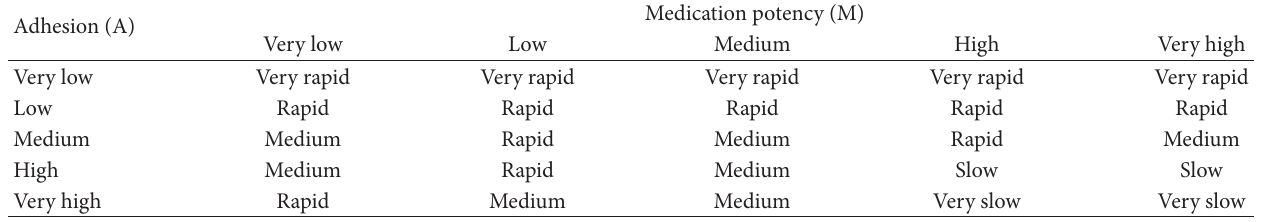
Table 2: Fuzzy rules for the period of virus replication.